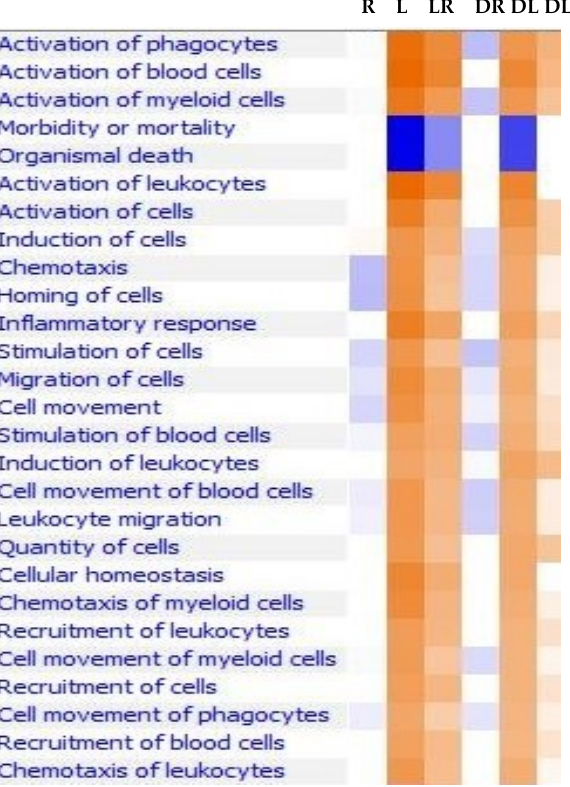
Figure 1. Cell functions modulated by RES, LPS, and LPS + RES in PBMCs from controls and PwD2. Human PBMCs from non-diabetic and PwD2 were treated with three different treatments and the vehicle control for 3 h. The RNA samples from controls and PwD2 were extracted from the cells and analyzed using RNAseq. These data were first extracted using the DEG analysis, followed by ingenuity pathways analysis. Cell functions for RES (R), LPS (L), LPS + RES (L + R), DRES (DR), DLPS (DL), and DLPS + RES (DL + R). Comparisons were made using their respective controls. Dark orange color denotes maximal effect, while dark blue color denotes minimal